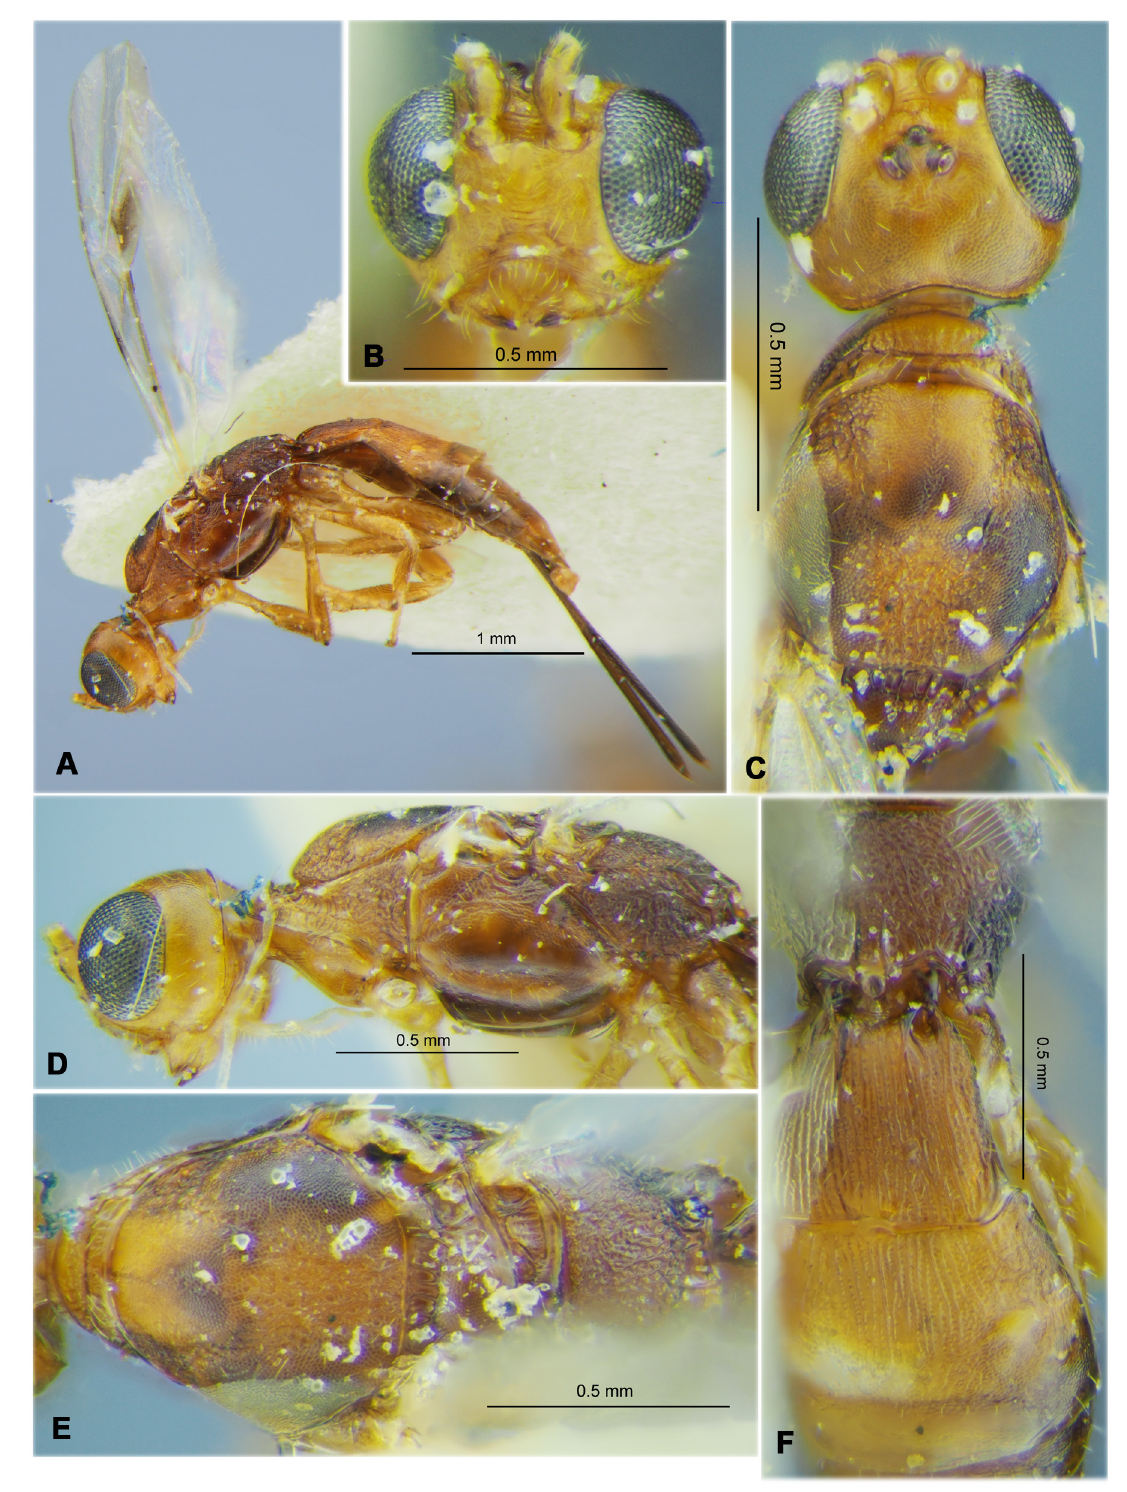
Fig. 30. Hecabalodes radialis Tobias, 1962, paratype, ♀ (ZISP). A . Habitus, lateral view. B . Head, front view. C . Head and mesoscutum, dorsal view. D . Head and mesosoma, lateral view. E . Mesosoma, dorsal view. F . Propodeum and first to third metasomal tergites, dorsal